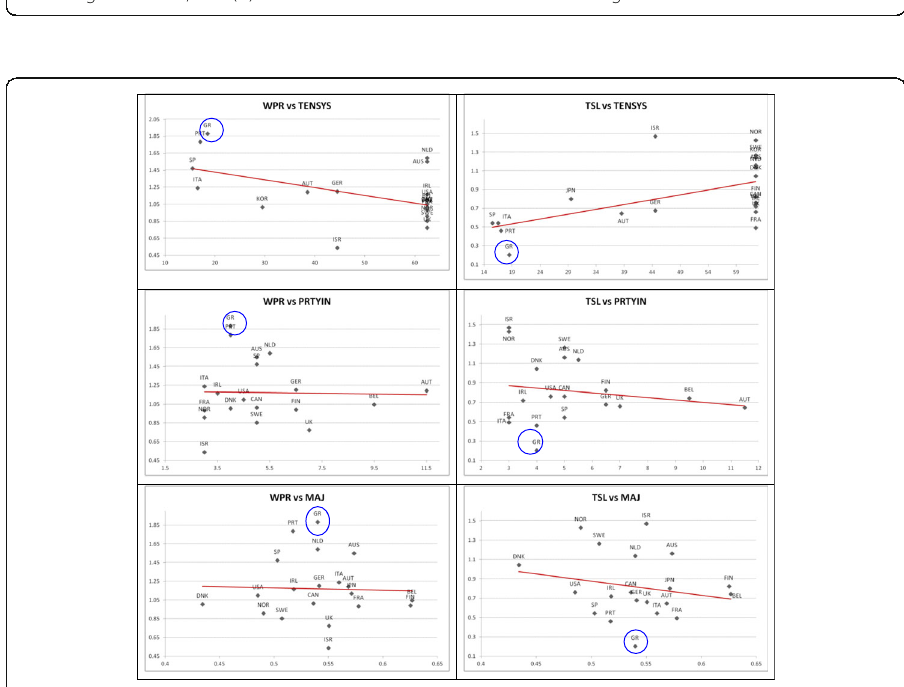
Fig. 13 Political institutions. Note : (i) Median values (maximum time span 1970 – 2010) and (ii) the red line is the linear regression